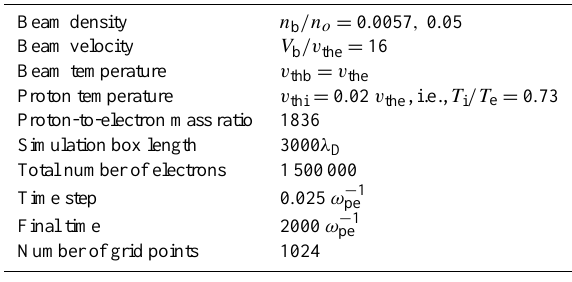
Table 1. PIC simulation